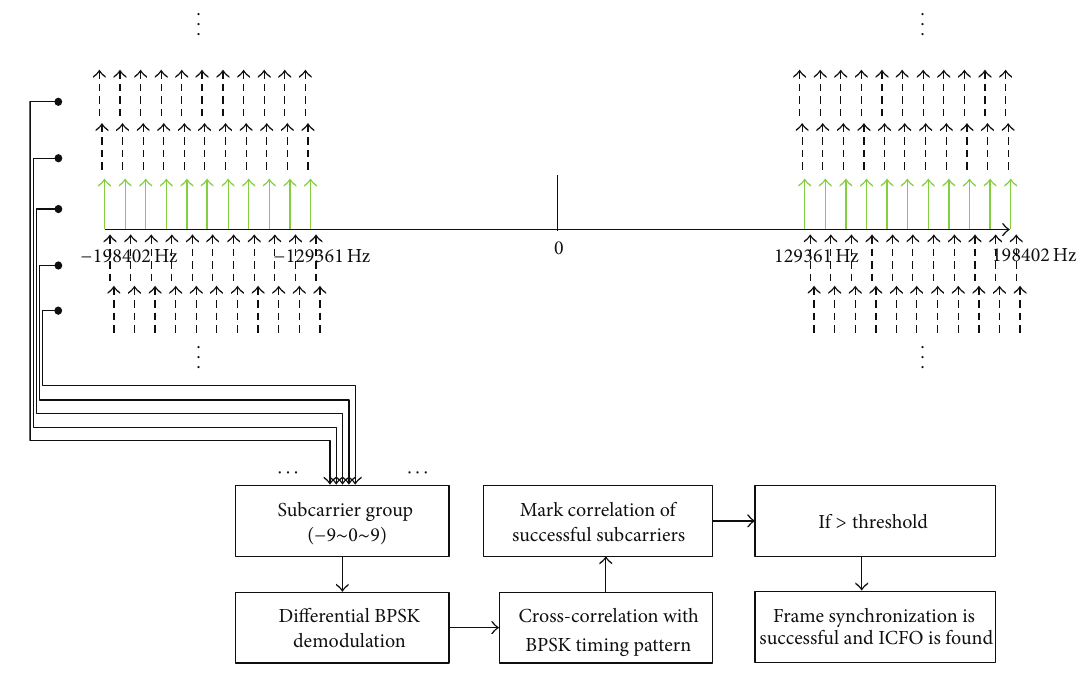
Figure 4: HD radio FM frame and ICFO synchronization.